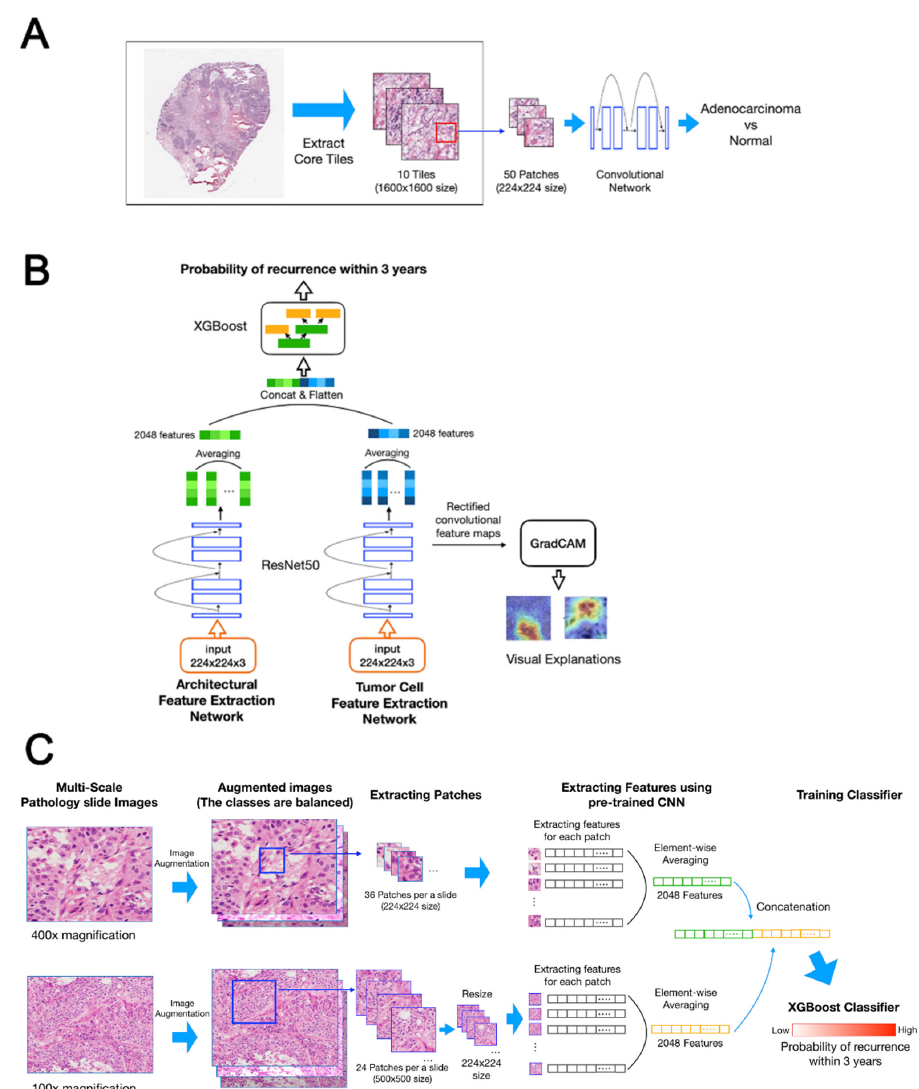
Figure 1. DeepRePath model. ( A ) Pre-training workflow. A total of 10 core tiles (1600 × 1600 pixels) excluding white areas were captured at 40× magnification from whole-slide histopathology images of lung adenocarcinoma (LUAD) from the Cancer Genome Atlas (TCGA). A total of 50 patches (224 × 224 pixels) were extracted from the core tiles. Resnet50 was trained to classify adenocarcinoma vs. normal tissue using the patches. This pre-trained Resnet50 model was used for transfer learning of the DeepRePath model. ( B ) DeepRePath network architecture. For multi-scale pathology images, DeepRePath was constructed using two separate convolutional neural networks (CNNs) (ResNet50). One network was for tumor cell patterns, and its input was the images captured at 400× magnification. The other network was for structural patterns, and its input was the images captured at 100× magnification. A total of 2048 features produced by both networks were concatenated into 4096 features. These features were used as inputs for the XGBoost classifier trained to predict the probability of recurrence within 3 years. For visualization of the DeepRePath model, the gradient-weighted class activation mapping (Grad-CAM) algorithm was used. ( C ) DeepRePath training workflow: Slide images whose class is in the minority are augmented by methods such as vertical flip, horizontal flip and standardization to fix class imbalance. In the case of a 400× magnification image, 36 patches with a size of 224 × 224 pixels were extracted from an image for tumor cell patterns. In the case of a 100× magnification image, the DeepRePath extracted 24 patches with a size of 500 × 500 pixels and then reduced them to a size of 224 × 224 pixels. Patches extracted from a 100× magnification image and patches extracted from a 400× magnification image were each passed through the CNN independently. The CNN extracted feature vectors with a size of 2048 from each patch, and the feature vectors were averaged element by element. The two averaged feature vectors from both 400× and 100× magnification images were concatenated. Finally, we predicted the probability of recur- rence within 3 years using XGBoost.